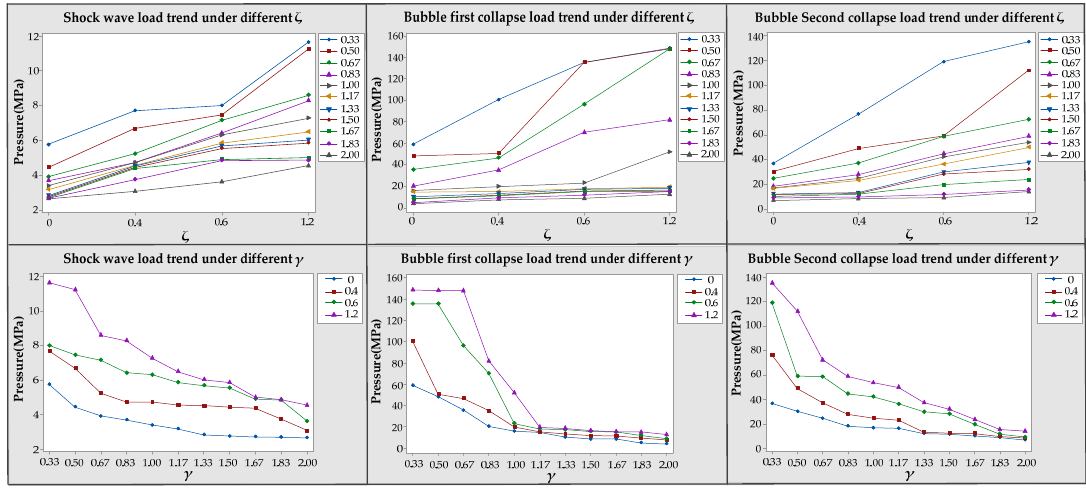
Figure 22. Load trend for 0.33 ≤ γ ≤ 2.00 and 0 ≤ ζ ≤ 1.2.